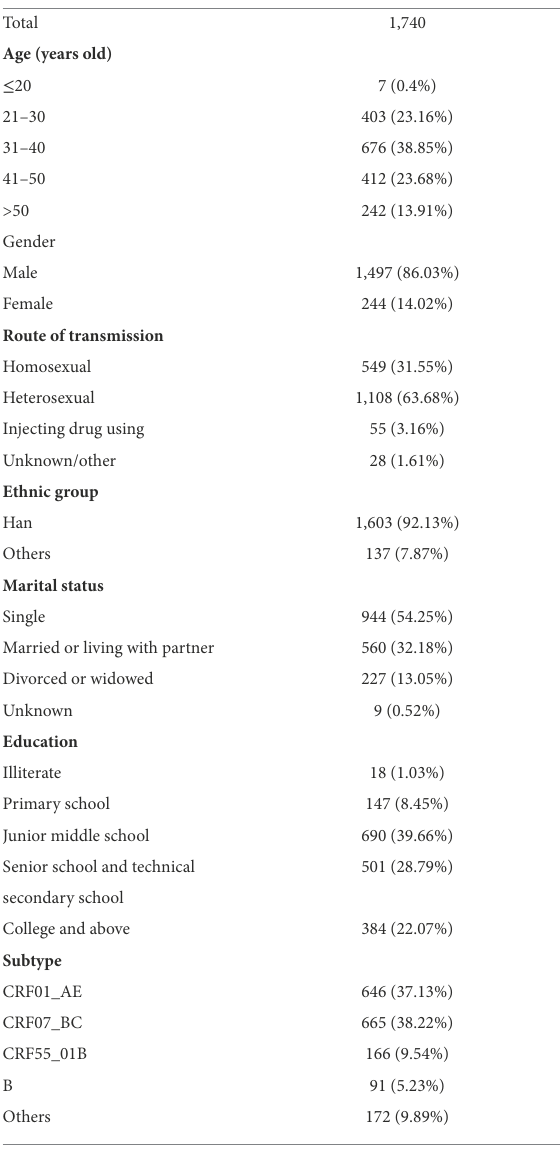
TABLE 2 Demographic characteristics of HIV-infected persons in Shenzhen, 2014–2015.